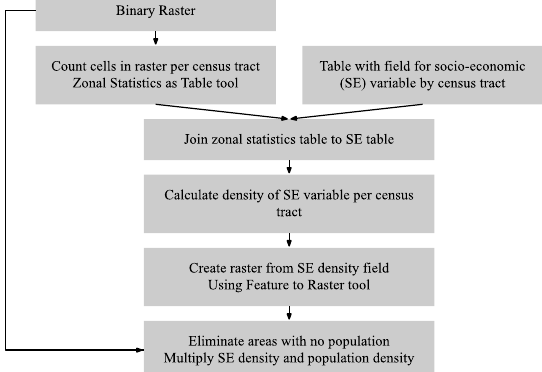
Figure 4. Steps to create density rasters for socio-economic